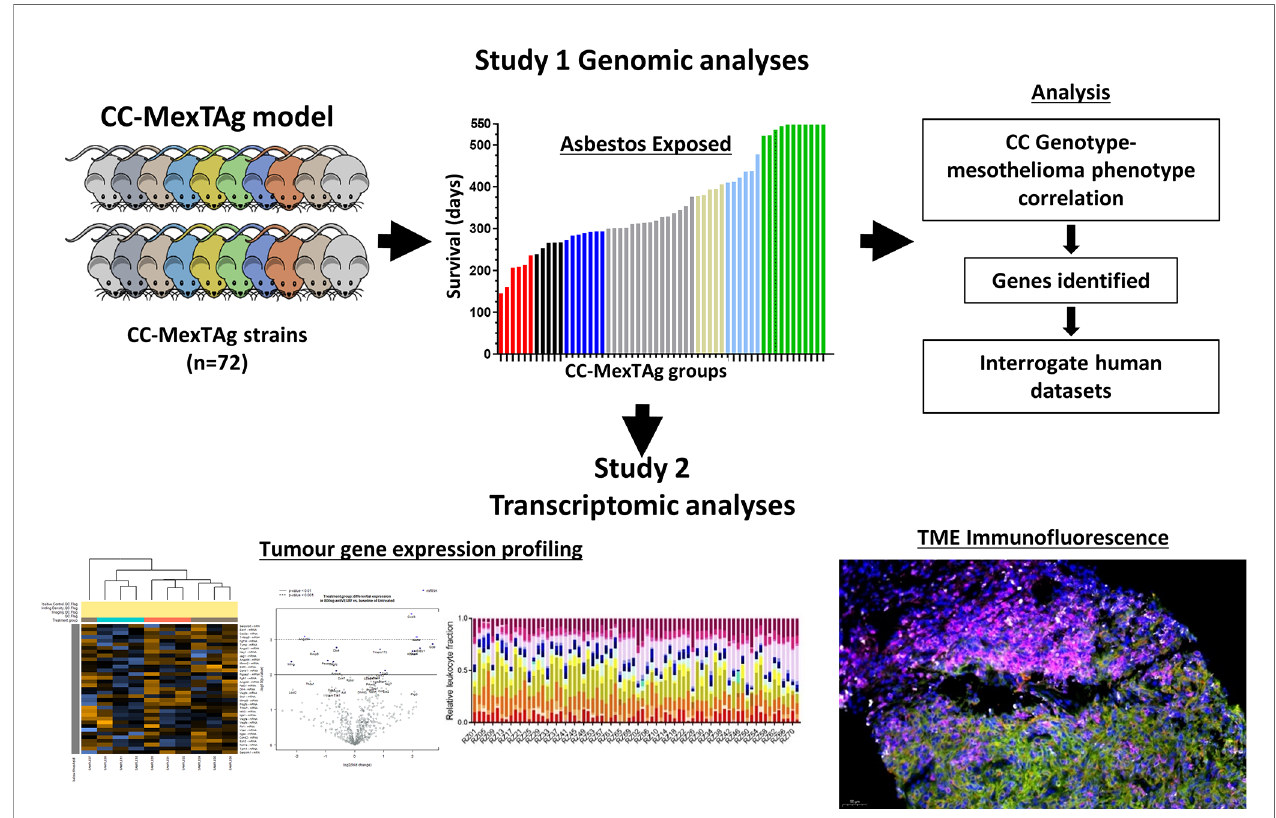
FIGURE 1 | A schematic of the CC ‐ MexTAg experimental design. The generation of CC ‐ MexTAg mice and their exposure to asbestos (Study 1): Brie fl y, candidate modi fi er genes will be mapped with mesothelioma ‐ free survival, as a quantitative trait using the GeneMiner Bioinformatics pipeline. Genome wide scans will be used to de fi ne chromosomal locations of peak single nucleotide polymorphism (SNPs) associated with each of the characterized mesothelioma phenotypes, such as disease progression, latency, overall survival, and mesothelioma incidence. Gene expression analysis and immuno fl uorescence analysis of tumors collected from CC ‐ MexTAg mice exposed to asbestos (Study 2): Comprehensive analyses of gene expression pro fi les and immune cell in fi ltrate of the tumor microenvironment will be performed to identify any differences between distinct CC ‐ MexTAg groups. These data will be correlated back to phenotypic data from Study 1, to build a broader understanding of the impact of host genetics on asbestos related disease